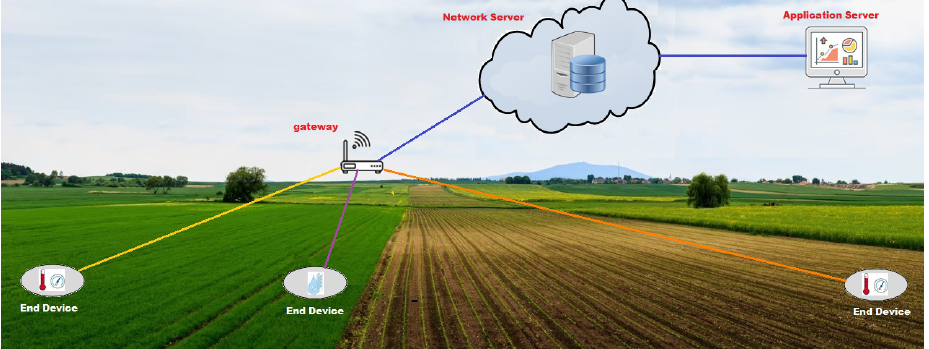
Figure 7. Evaluation